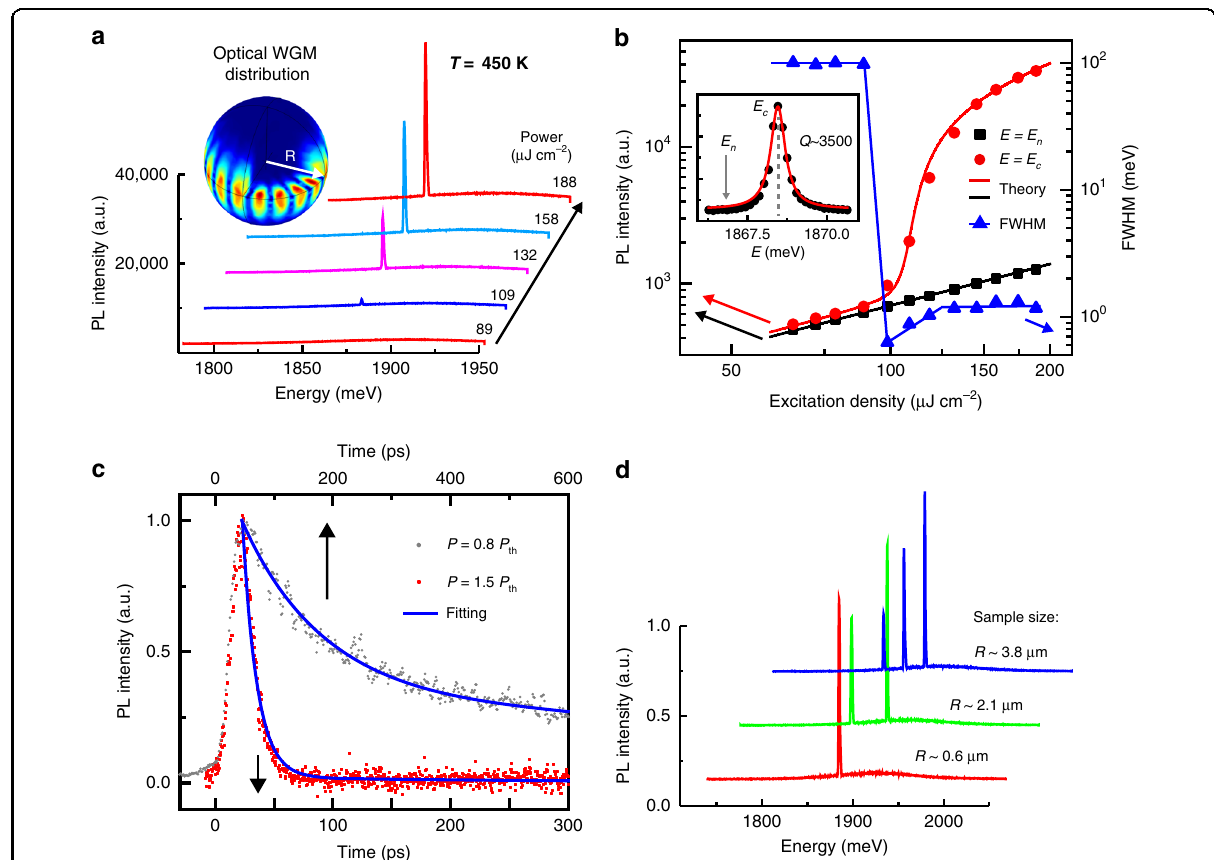
Fig. 2 Single-mode lasing characteristics of CQDAMs at high temperature. a Power-dependent emission spectra of a typical CQDAM at 450 K. Inset: three-dimensional optical WGM distribution based on a microsphere with radius R = 590 nm by theoretical simulation. b The excitation density VS the PL intensities at the cavity resonance energy ( E c : 1868 meV) and the nonresonant energy ( E n : 1863 meV). Plots of emission FWHM of PL spectra VS excitation density. Inset: Lorentzian fi tting of the lasing peak with an FWHM of ∼ 0.6 meV, corresponding to a Q factor of ∼ 3500. c Typical PL decay pro fi les of the emission measured under different excitation densities of 0.8 P th , and 1.5 P th . The solid lines are the fi tting results based on biexponential decay functions. The spontaneous and stimulated radiation lifetimes are 300 and 13 ps, respectively. d The resonant optical modes of CQDAMs with different sizes. Multimode lasing can be obtained and the spacing between two adjacent modes decreases with the increase of cavity